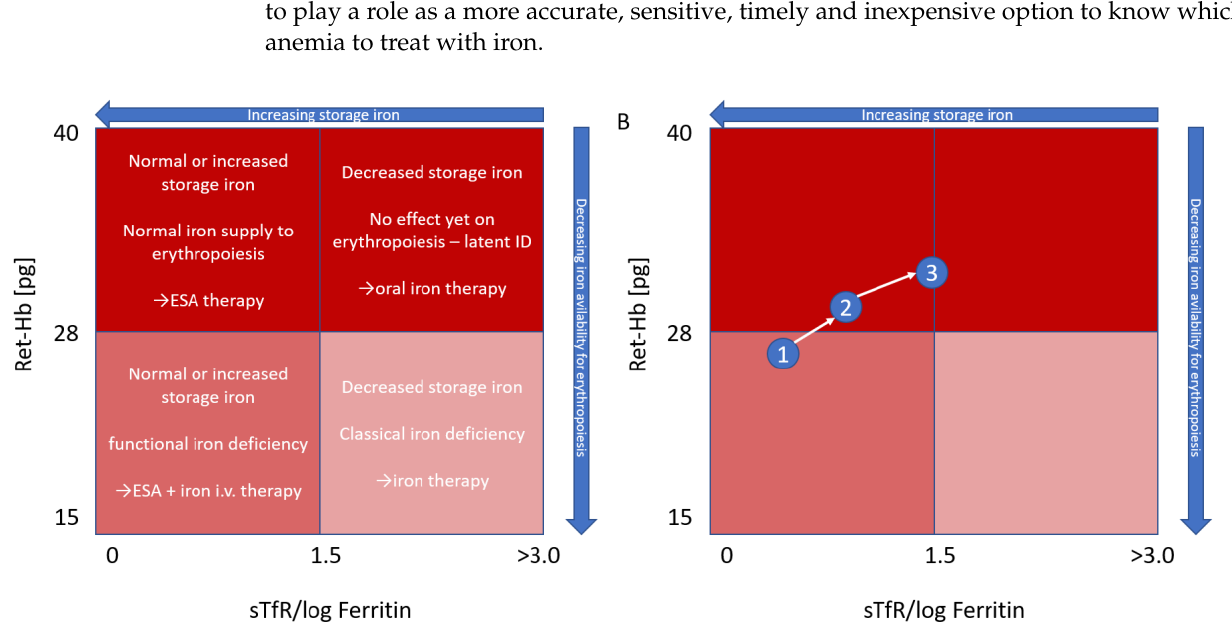
Figure 1. Modified Thomas plot [38]. Characterization ( A ) and monitoring ( B ) of anemia based on reticulocyte hemoglobin and the sTfR/log ferritin index. In ( B ), an initial functional iron deficiency (1) is first treated with ESA and i.v. iron therapy (2). Subsequent focus on ESA therapy leads to reduction of storage iron to a borderline level, while hemoglobinization of reticulocytes is still normal (3), Ret-Hb = Ret-H e = mean reticulocyte hemoglobin.